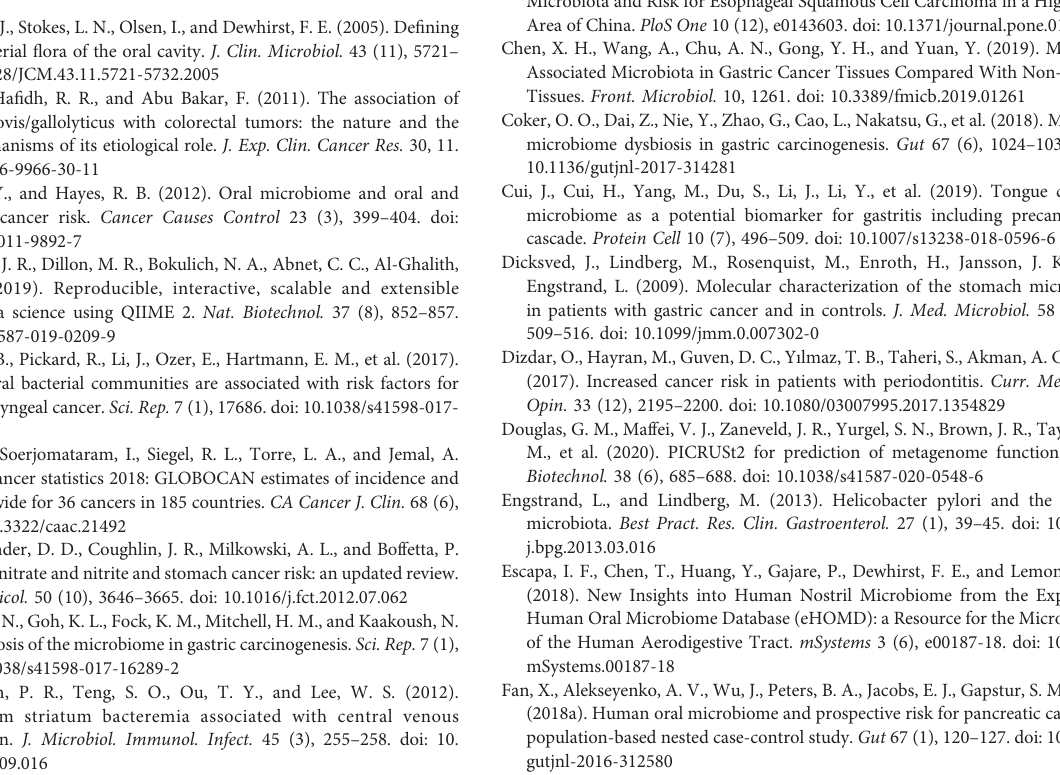
Supplementary Table 1 | Differences in the salivary microbiota compositions among patients at different progressive histological stages of gastric tumorigenesis. Supplementary Figure 1 | The salivary microbiota biodiversity in AG patients with and without intestinal metaplasia. The alpha diversity of salivary microbiota was measure at the ASV level by using (A) Shannon index, (B) Chao1. Comparison between intra-group and inter-group community distances by (C) unweighted UniFrac distance matrix and (D) weighted UniFrac distance matrix revealed no signi fi cant difference between the microbiota compositions between AG patients Supplementary Figure 2 | The salivary microbiota biodiversity in GC patients with different histological grades. The alpha diversity of salivary microbiota was measure at the ASV level by using (A) Shannon index, and (B) Chao1 index. Comparison between intra-group and inter-group community distances by (C) unweighted UniFrac distance matrix and (D) weighted UniFrac distance matrix revealed no signi fi cant difference between the microbiota compositions among patients with well differentiated (W), moderately differentiated (M), and poorly differentiated(P) gastric tumor. P value was calculated by Anosim comparing the intra-group distances with between-group distances. Supplementary Figure 3 | The salivary microbiota compositions in patients at different histological stages of gastric tumorigenesis. The relative abundances of